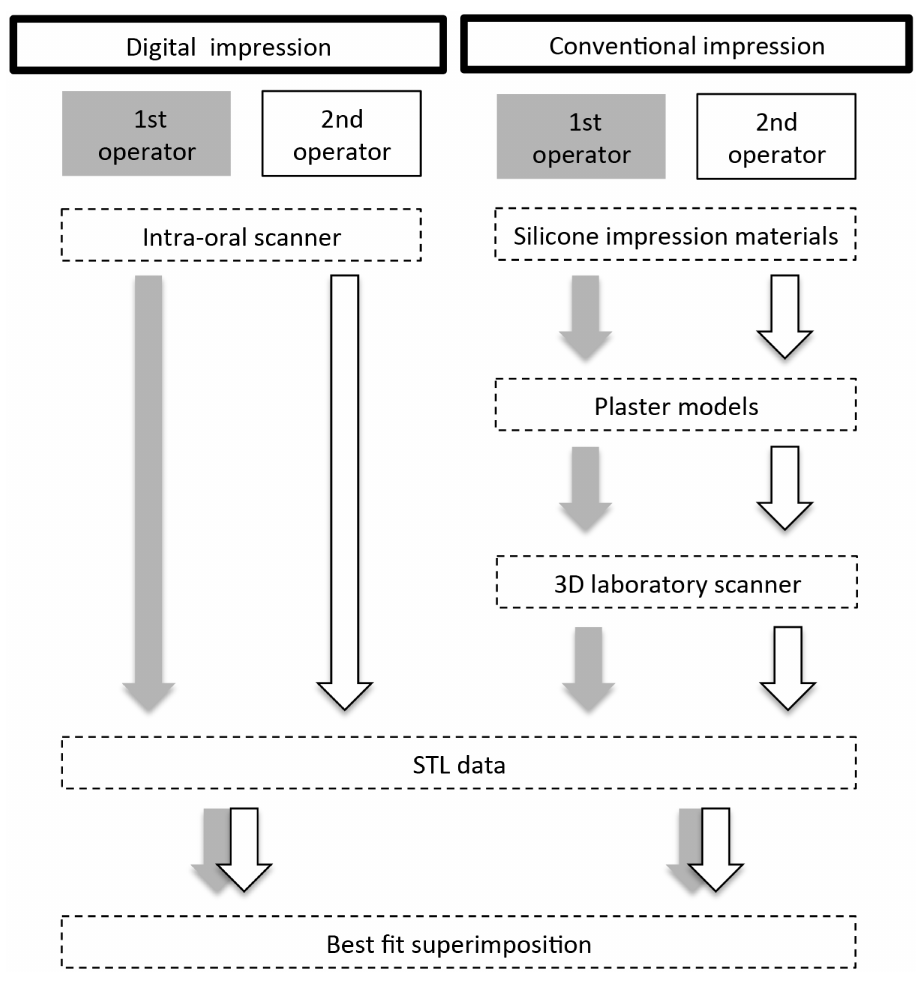
Fig 1. Flow chart demonstrating experimental design of the